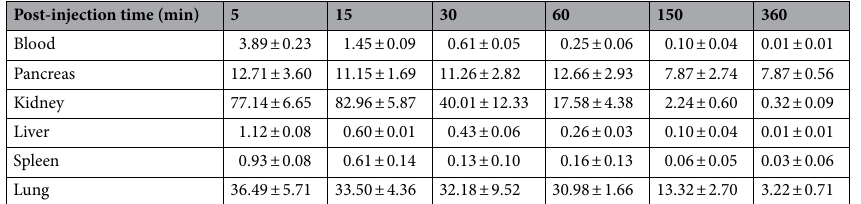
Table 1. The biodistribution study of [ 18 F]FB(ePEG12)12-exendin-4. The data are calculated as uptake values of the organ per injected dose of the probe (%ID/g) and expressed as the mean ± SEM. The male ddY mice were used (n = 4 for each time